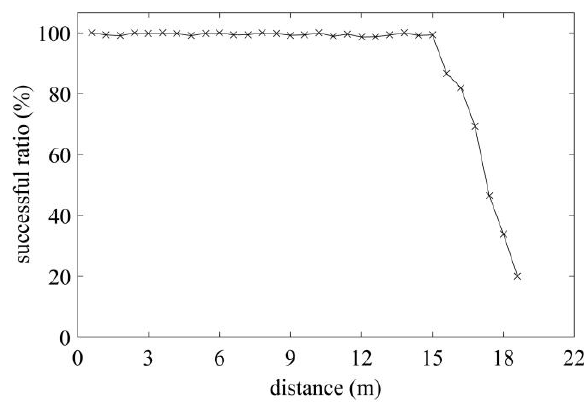
Figure 10. Measured successful ratio under different distance.